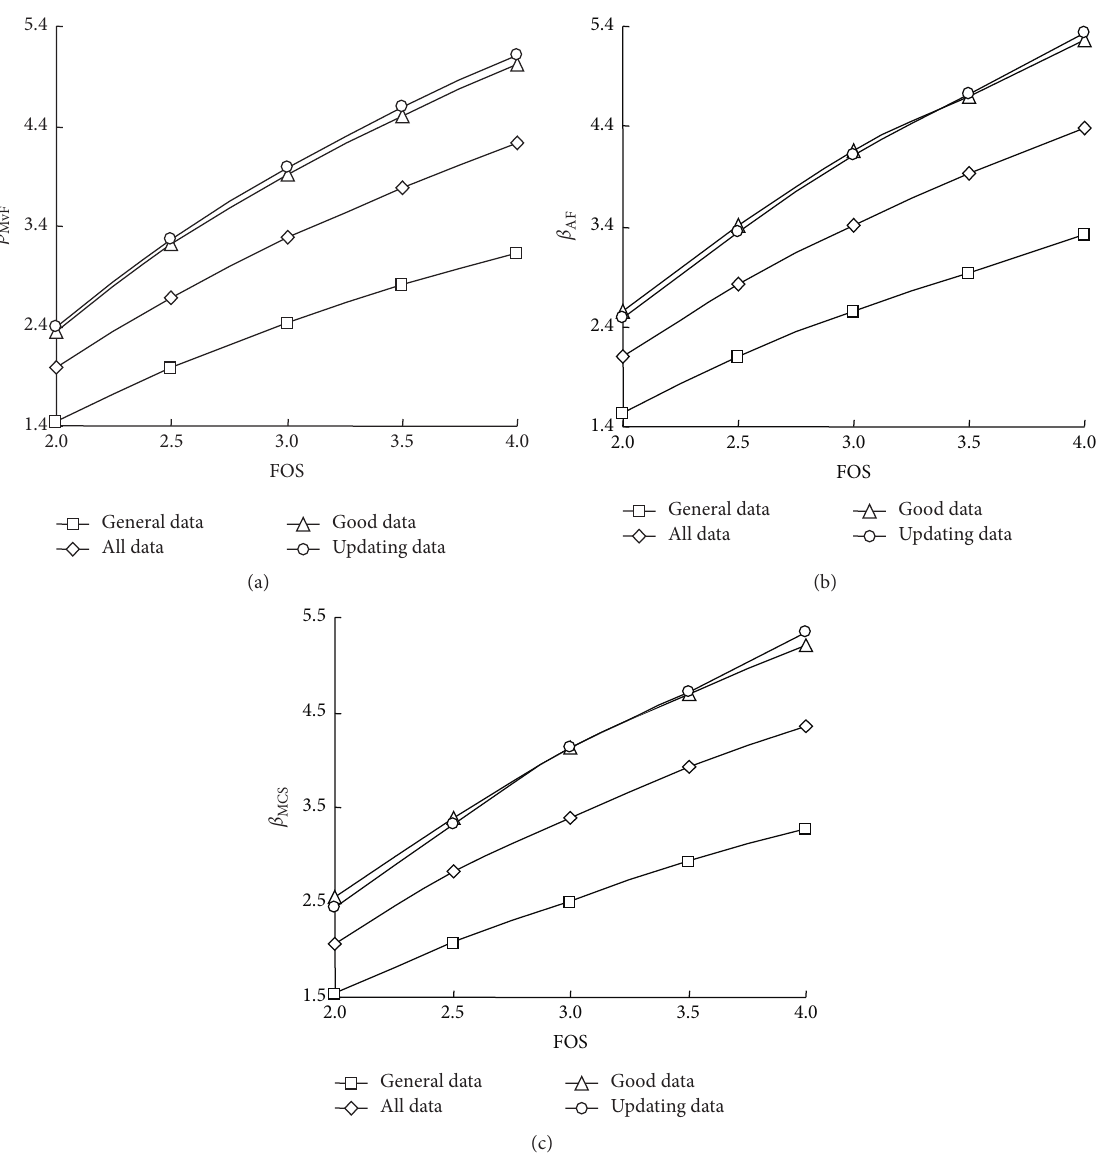
Figure 3: Reliability index in noncohesive soil. (a) First-order reliability method. (b) Design point method. (c) Monte Carlo simulation